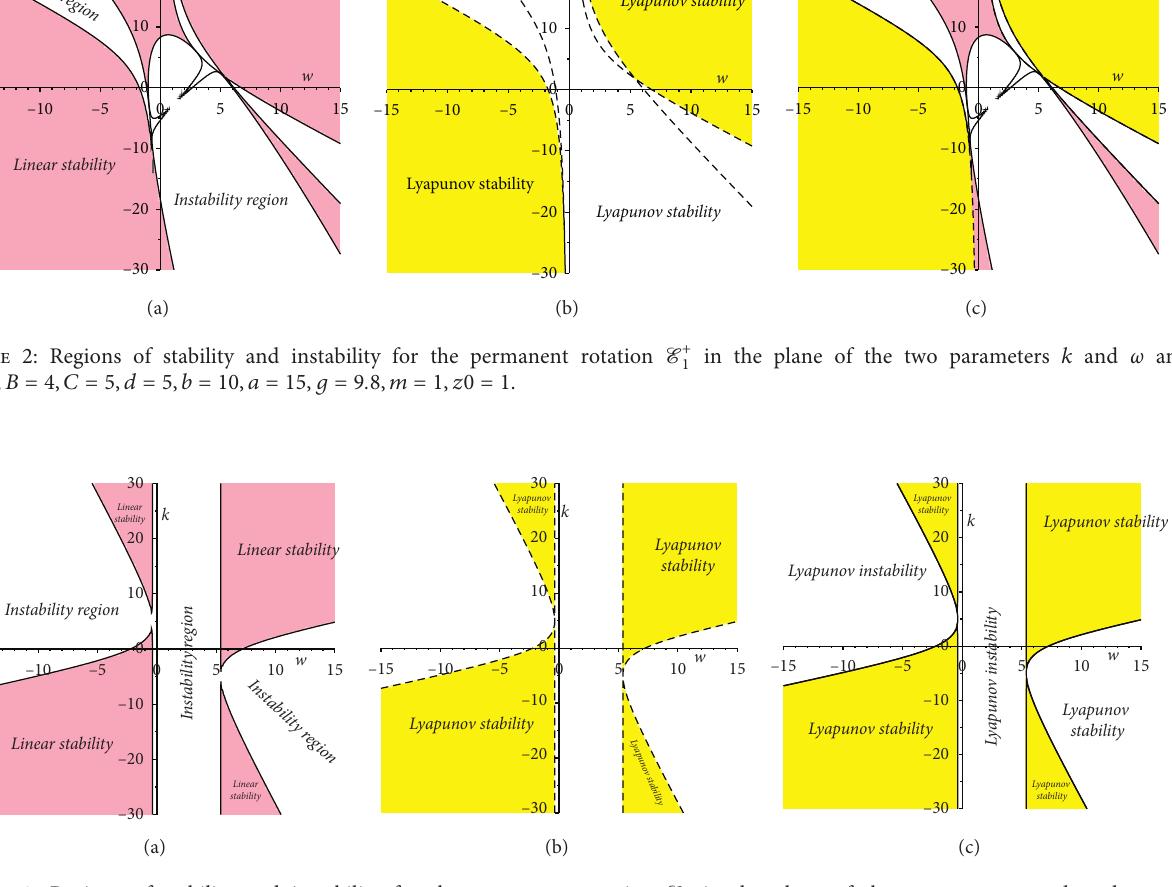
in the plane of the two parameters k and ω and 2